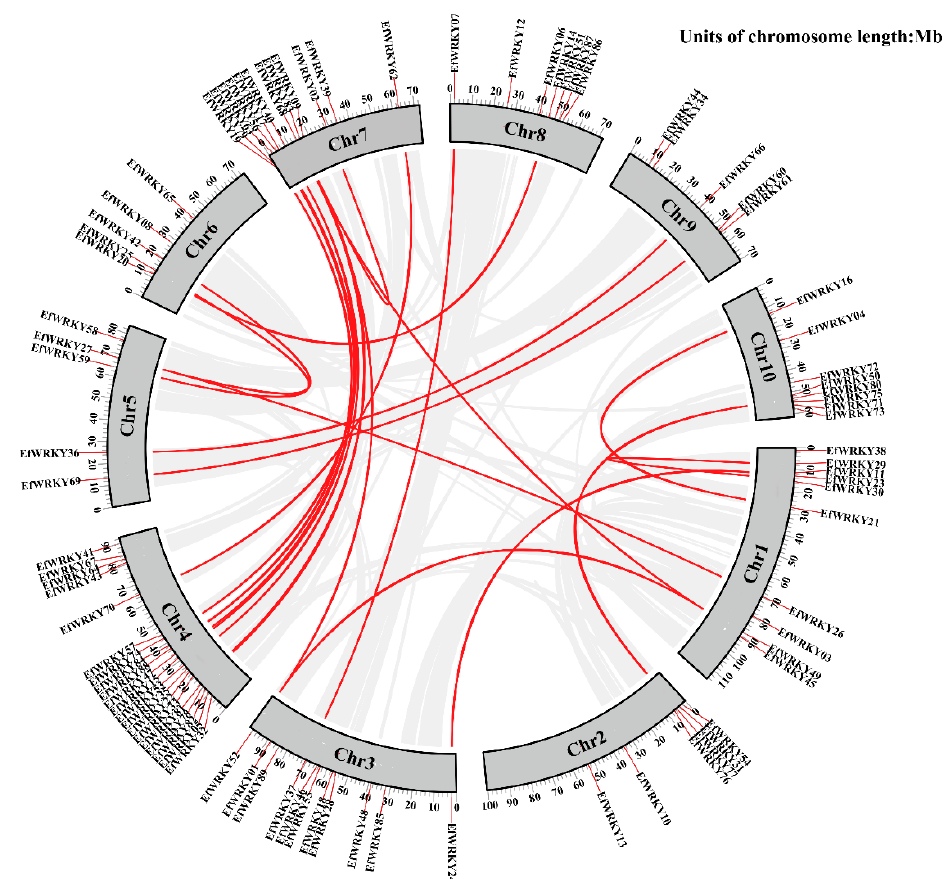
Figure 5. The intrachromosomal segmental duplication map of the WRKY genes in E. fulvus . Red lines are WRKY gene pairs genomes between plant genomes. Gray lines are collinear blocks for interplant genomes.